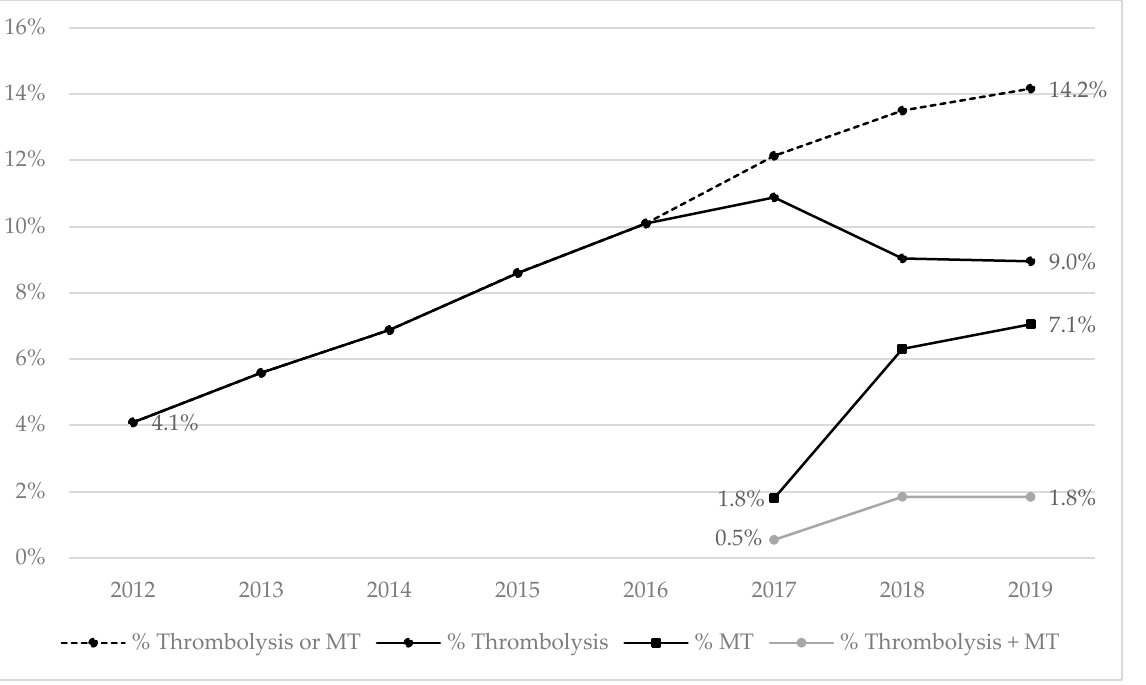
Figure 3. Time trends in the rates of thrombolysis and mechanical thrombectomy (MT) in patients hospitalized for ischemic strokes from 2012 to 2019. Note: Thrombolysis data have only been available since 2012; MT has only been referenced as a medical procedure since August